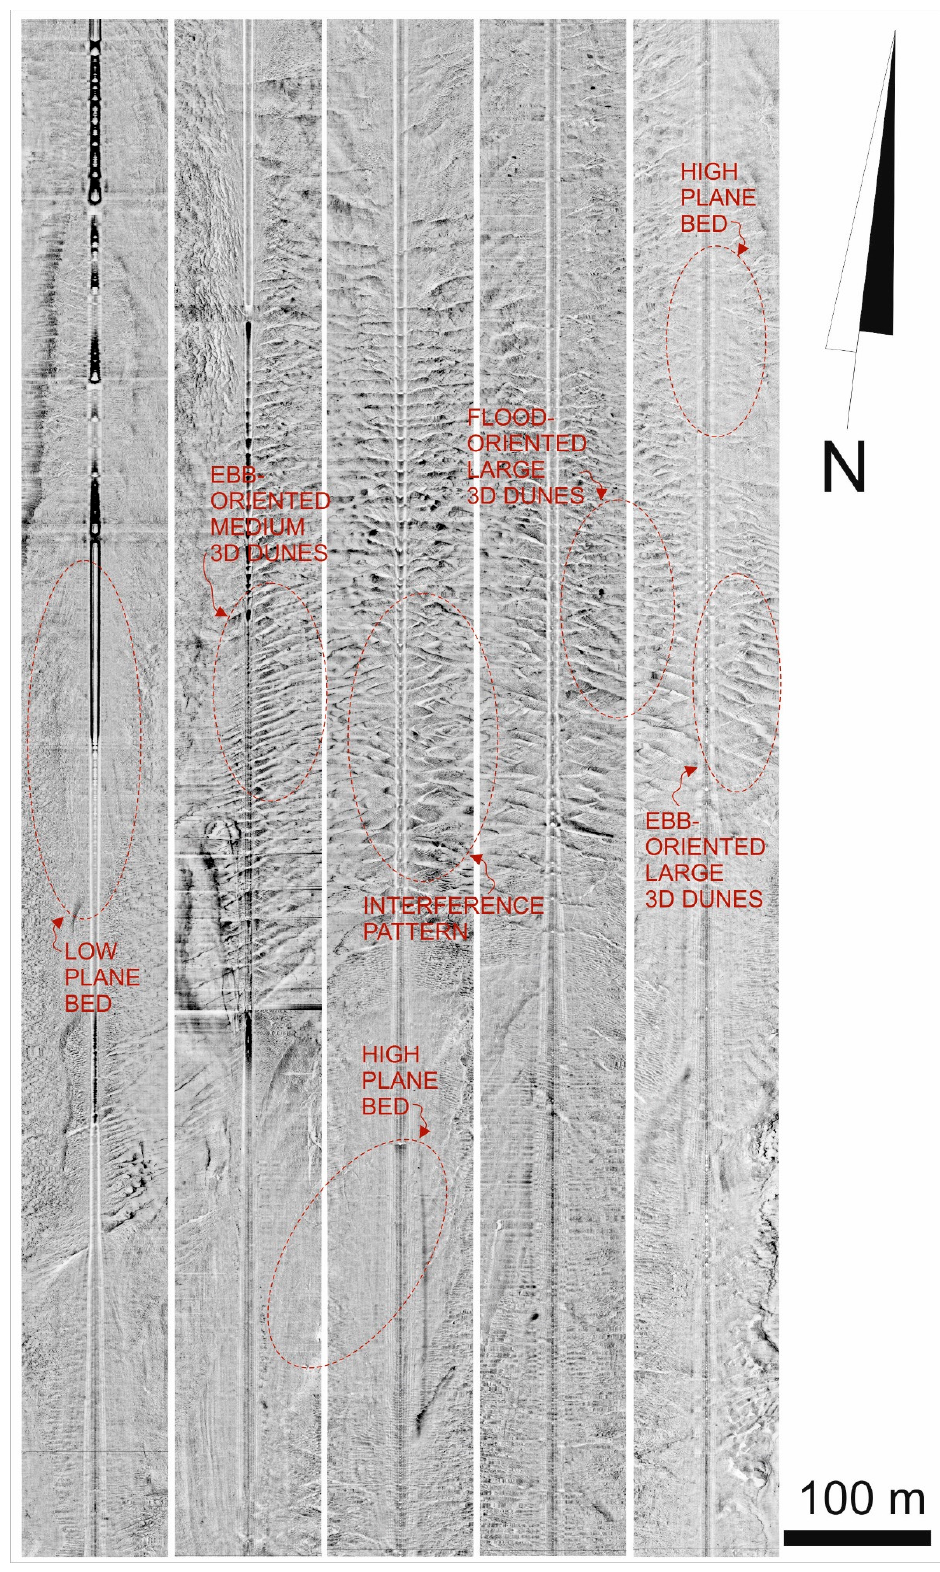
Figure 7. Side-Scan Sonar records covering the outer area. The main distinguished bed features are indicated.